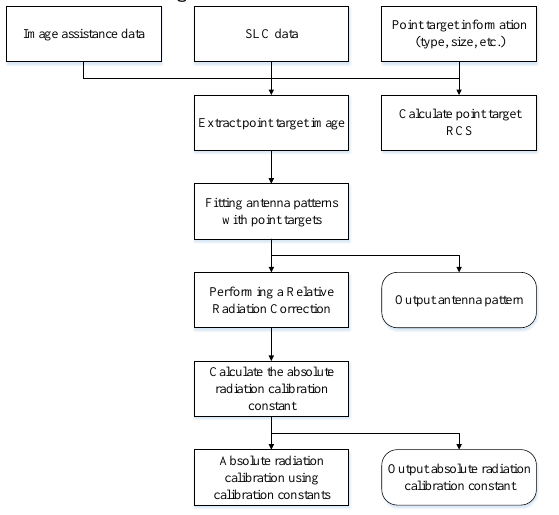
Figure.1 Point Target Radiation Calibration Flow Chart